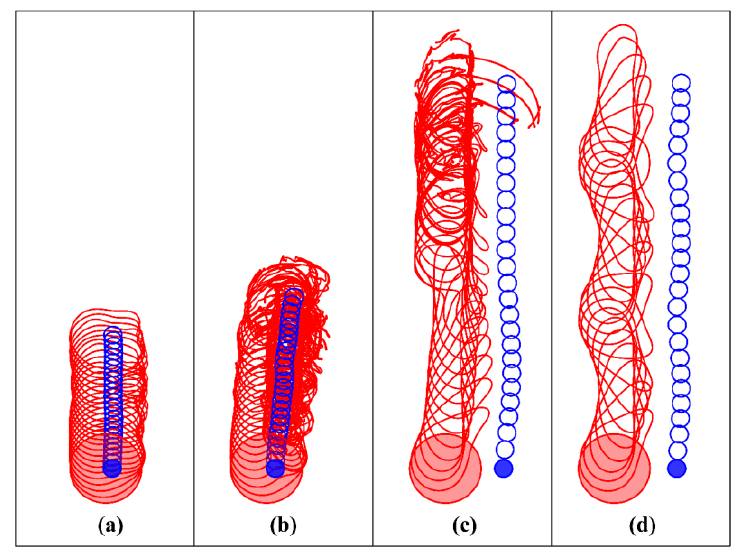
Figure 6. Gallery of the superposed vortex contours in the upper layer (red lines) and middle layer (blue lines) for r 1 = 4, r 2 = 1 and P 1 = − P 2 = 0.6 at times t = 0, 1, 2, ... , 24, and di ff erent distances between the vortices: ( a ) L = 0.71; ( b ) L = 1.0; ( c ) L = 6.5; ( d ) L = 7.0 (the markers in Figure 5 correspond to these values of L ). Vortex patches at t = 0 are filled. The time evolution goes from bottom to top in each panel.